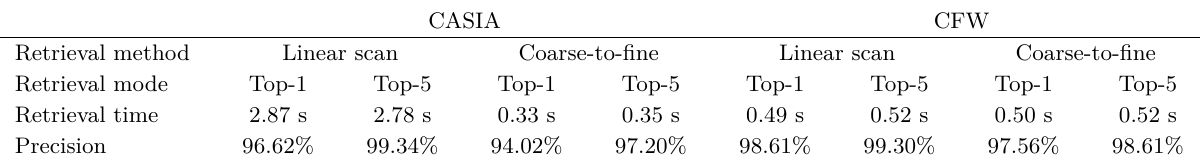
Table 2 Face retrieval results for CASIA and CFW; retrieval time is the average search time per probe face